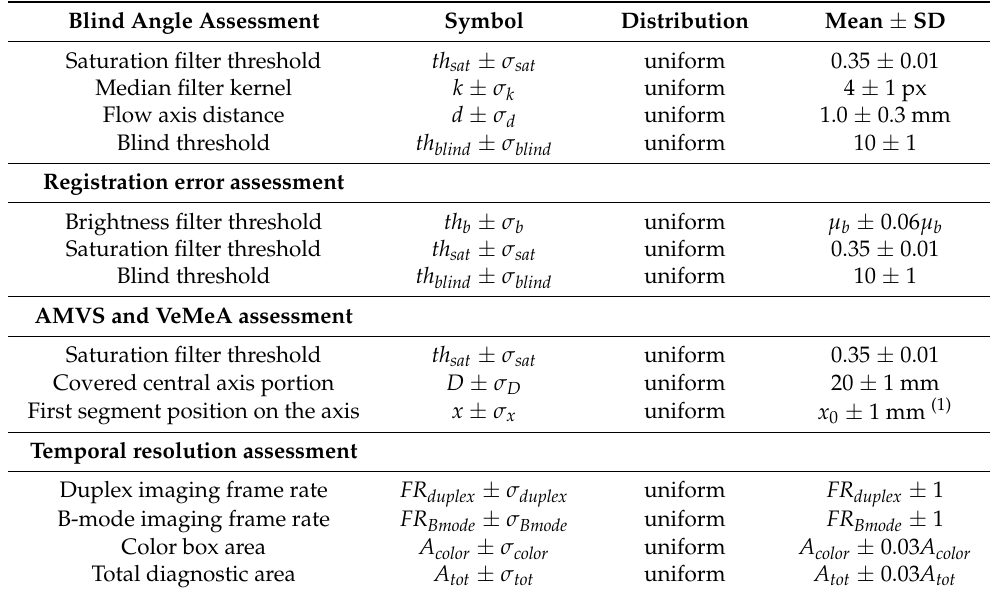
Table 8. Distribution setting in MCSs for measurement uncertainty estimation of the image analysis method for QC test parameters